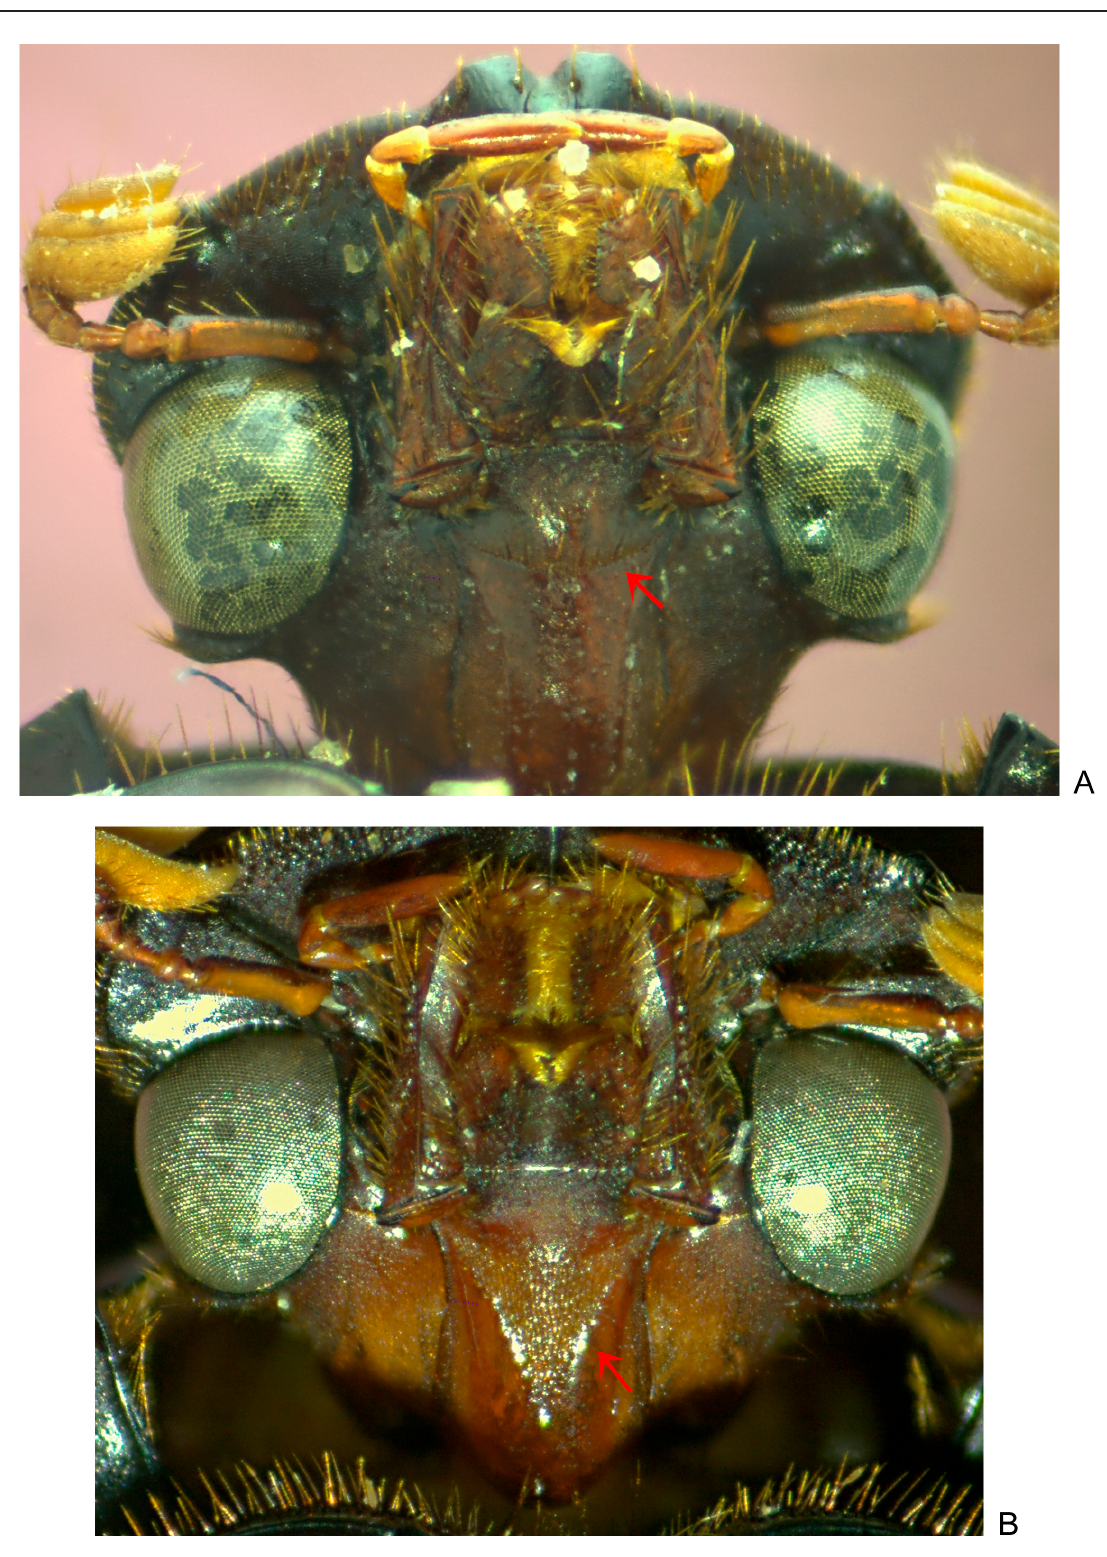
Fig. 8. Head, ventral view. A . Sylvicanthon bridarollii (Martínez, 1949). B . S. proseni (Martínez, 1949) stat. et comb. nov. See the differences in the shape of the suture between submentum and gula in these two species (red arrows), which is rounded in S. bridarollii and most of the other species of Sylvicanthon , while it has a ‘Y’-shape in the two representants of the